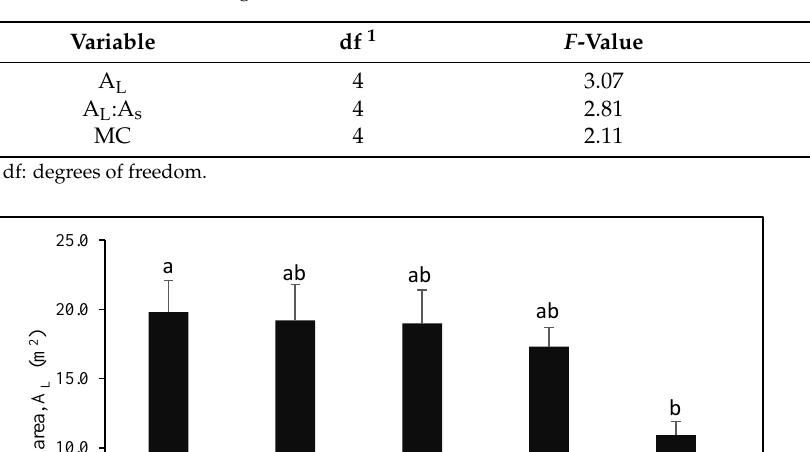
Table 3. Means and standard errors of the ratio of tree projected leaf area and sapwood area (A L :A S ) and foliage moisture content expressed on dry weight basis (MC) 34 months following stem inocu- Table 2. Probabilities of a greater F -value ( p > F ) from one-way analyses of variance of tree projected lation of P. taeda trees with L. terebrantis near Eufaula, AL, USA. leaf area (A L ), ratio of tree projected leaf area and sapwood area (A L :A S ), and foliage moisture content (MC) 34 months following stem inoculation of P. taeda trees with L. terebrantis near Eufaula, AL.